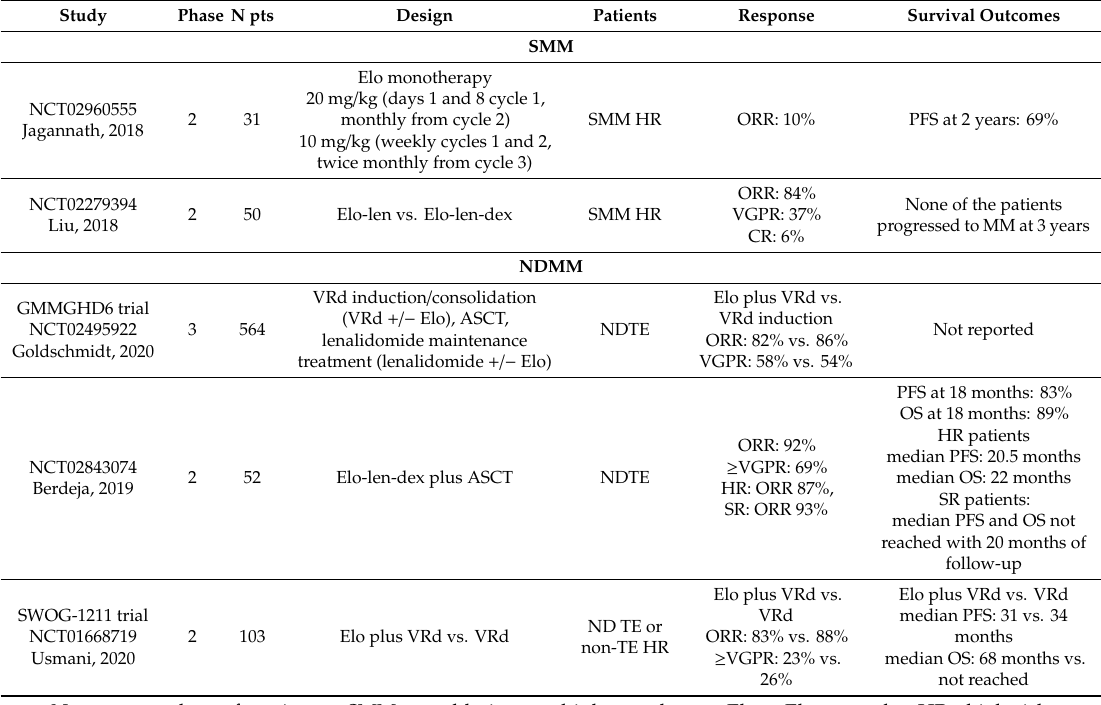
Table 2. Results of selected clinical trials with elotuzumab for smoldering and newly diagnosed multiple